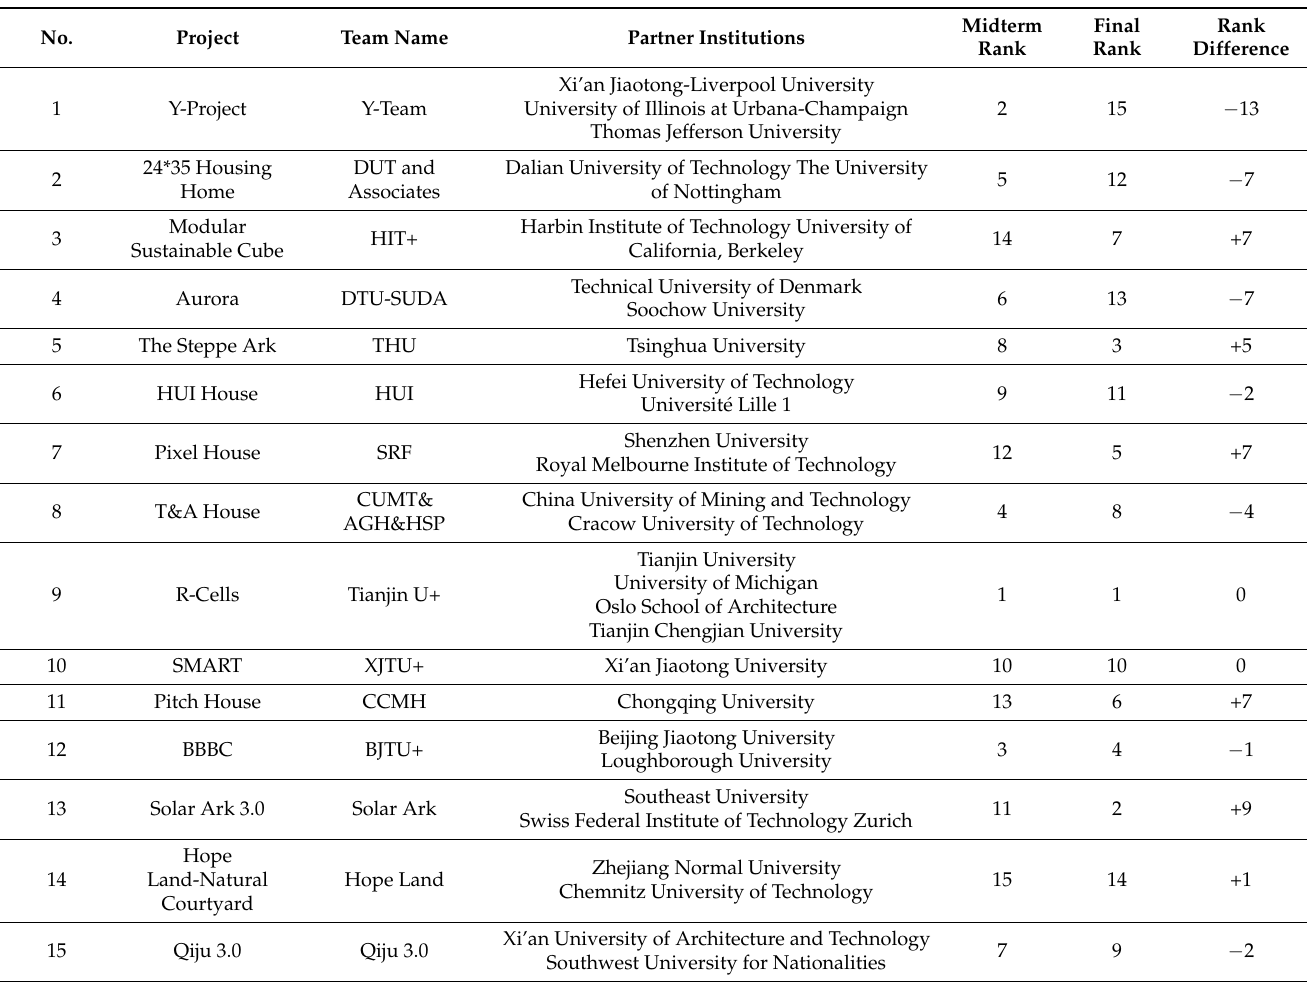
Table 8. Comparison of midterm and final rank of SDC2021